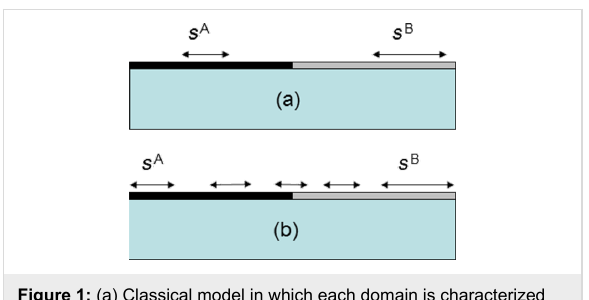
Figure 1: (a) Classical model in which each domain is characterized by its own supposedly constant surface stress. (b) When taking into account surface elasticity, the surface stress at mechanical equilib- rium is no longer constant except far from the